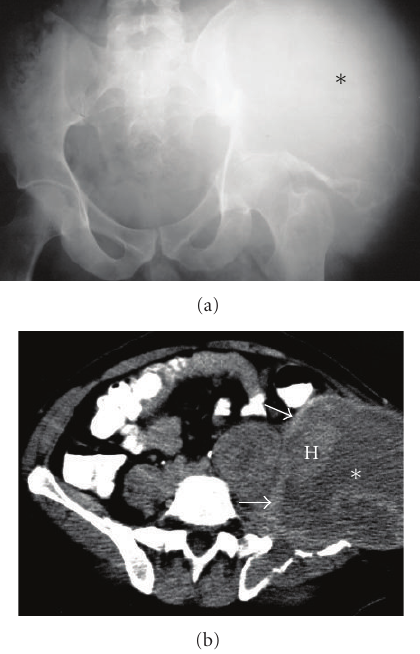
Figure 11: Hemophilic pseudo tumor. A 60-year-old male with hemophilic pseudo tumor of the left iliac wing. Plain radiograph (a) of the pelvis illustrating a large mass lesion (asterisk) destroying the left ilium and the acetabulum. Axial CT (b) of the pelvis demonstrates a large soft tissue density mass, centered within the left ilium (asterisk). Several areas of heterogeneous density (H) representing recent bleeds are present within the mass. Close inspection reveals a thin ballooned cortex (arrows) of the a ff ected ilium.